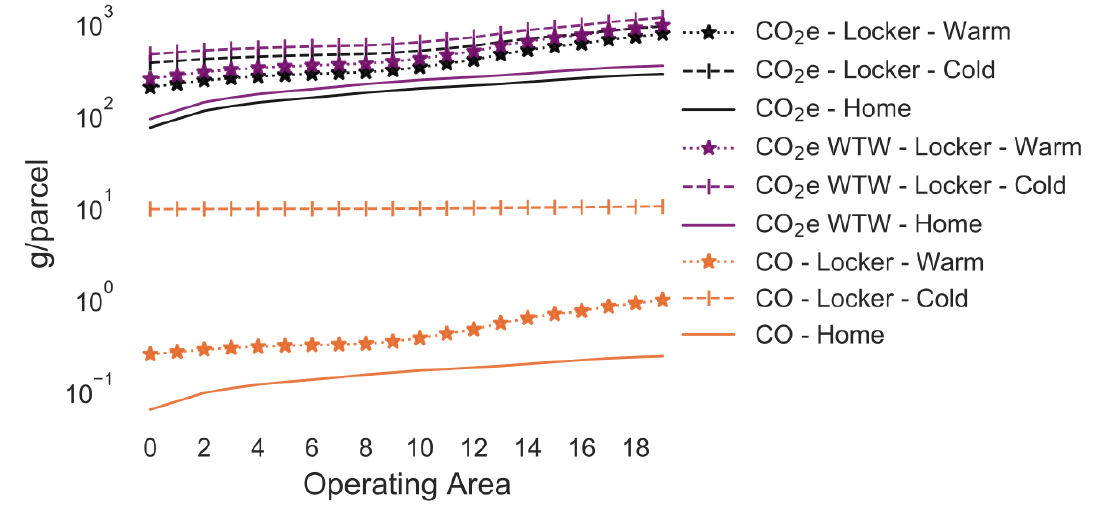
Figure 3. Selected pollutants for home delivery and delivery to lockers.